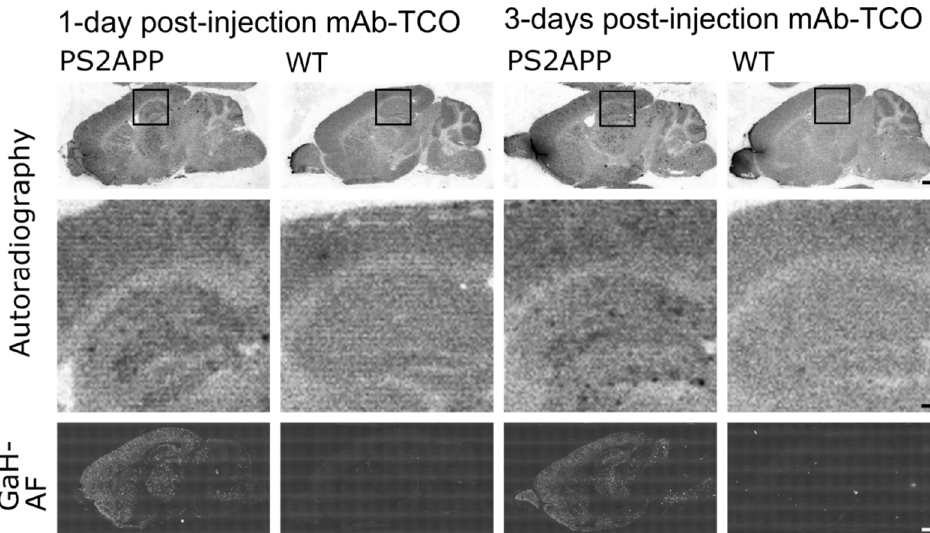
Figure 5. Maintained reactivity of the TCO moiety in vivo. Autoradiography results of mouse brain sections from PS2APP and WT controls following ex vivo click-reaction using the Tz, 1 day and 3 days post-injection of mAb–TCO (top row, scale bar = 1 mm). The magnification shows a clear, autoradiographic signal in brain sections of the transgenic animal and not the WT (middle row, scale = 200 µm). Immunohistochemical staining (GaH-AF) proves mAb–TCO enters the brain and is responsible for the detected signal (bottom row, scale bar = 1 mm). Table 1. Number of plaques detected by autoradiography after ex vivo click reaction. Data expressed as spots/mm 2 (plaque density).